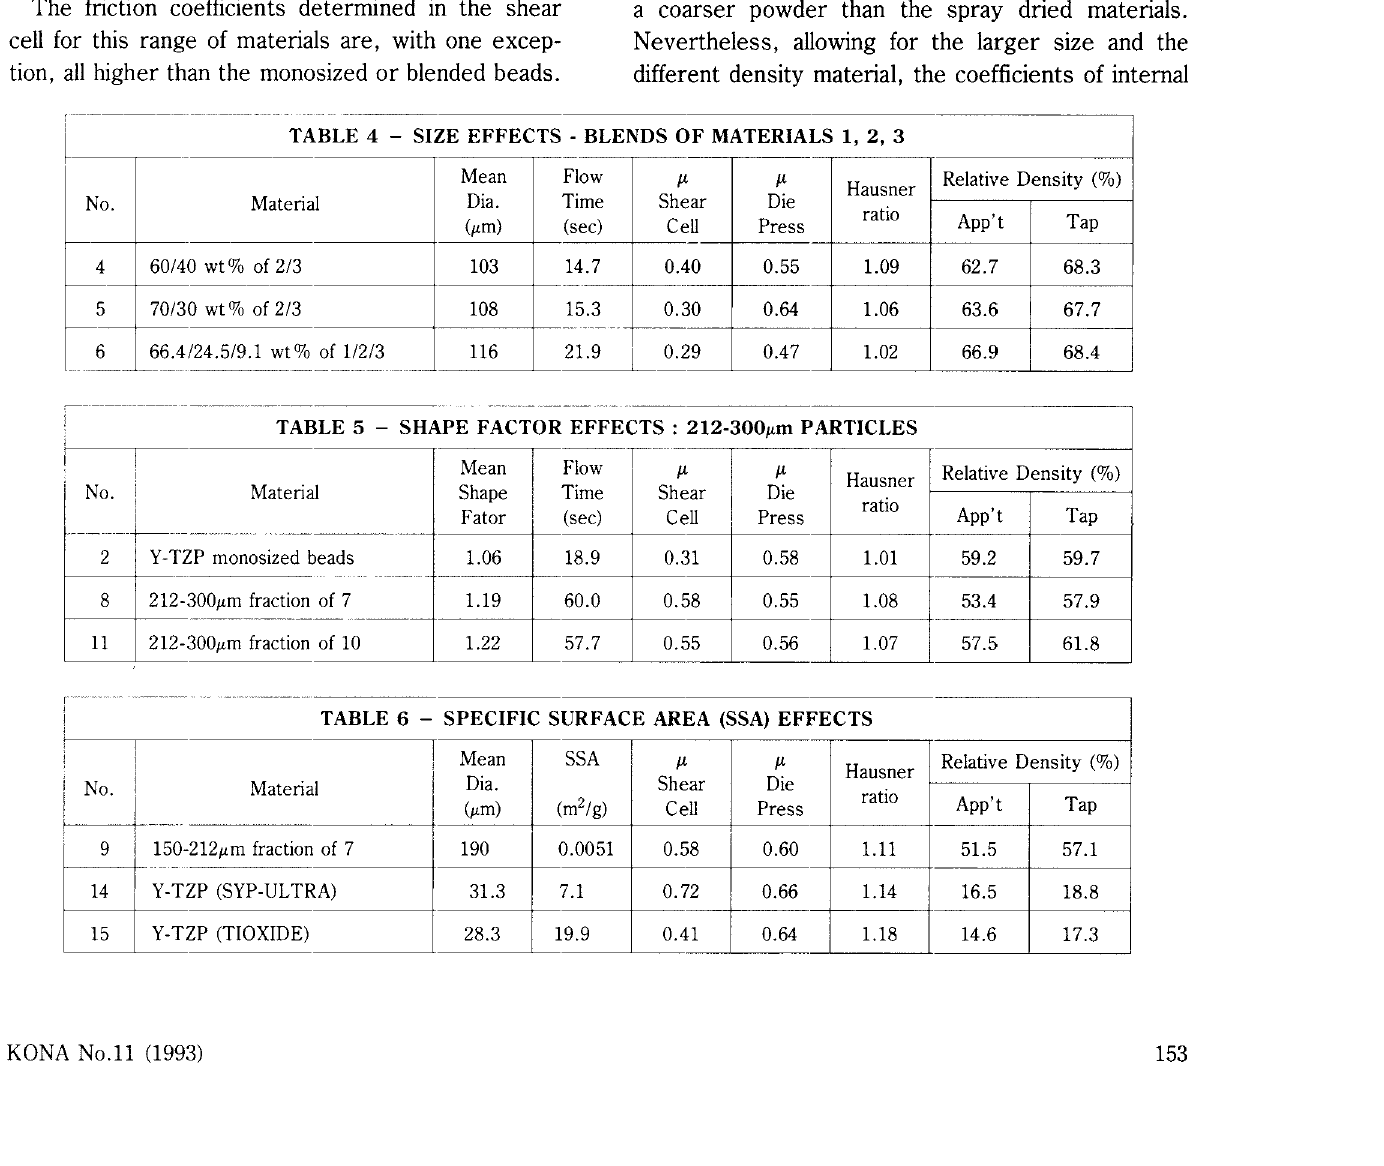
TABLE 6 - SPECIFIC SURFACE AREA (SSA)